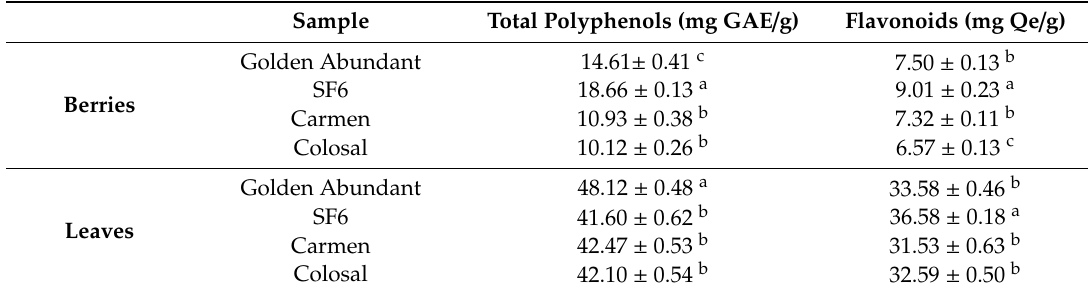
Table 2. Total content of phenolic compounds in sea